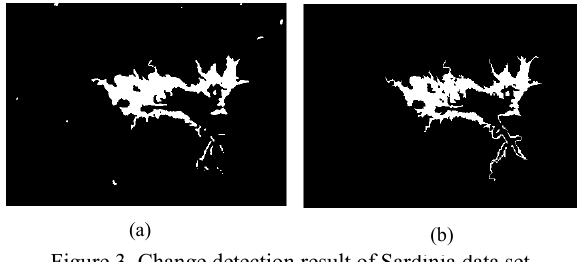
Figure 3. Change detection result of Sardinia data